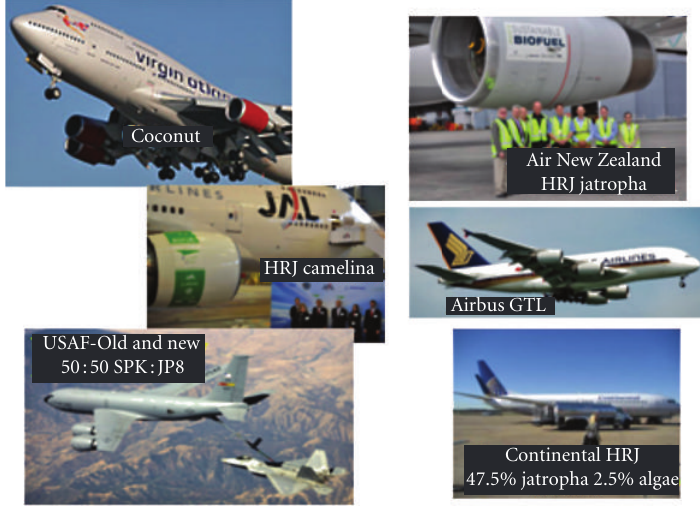
Figure 6: Alternate-fueled flight testing.